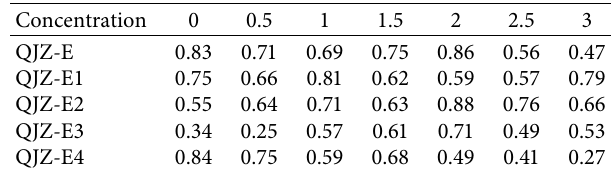
Table 1: Cell survival rate.